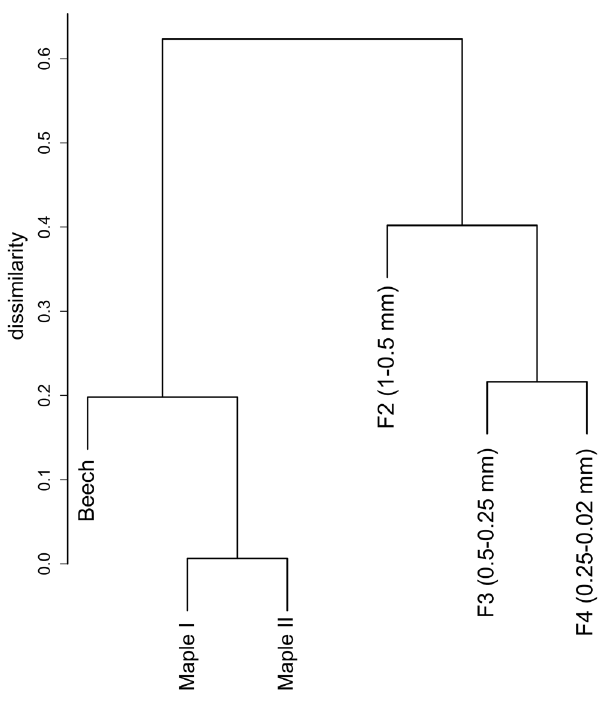
Figure 2. Cluster dendrogram of the fungal community composition data presenting the dissimilarity of the leave samples and the particle size fractions based on pyrosequencing. Data based on a Kulczynski similarity matrix, clustered with UPGMA (average) method (based on Dataset